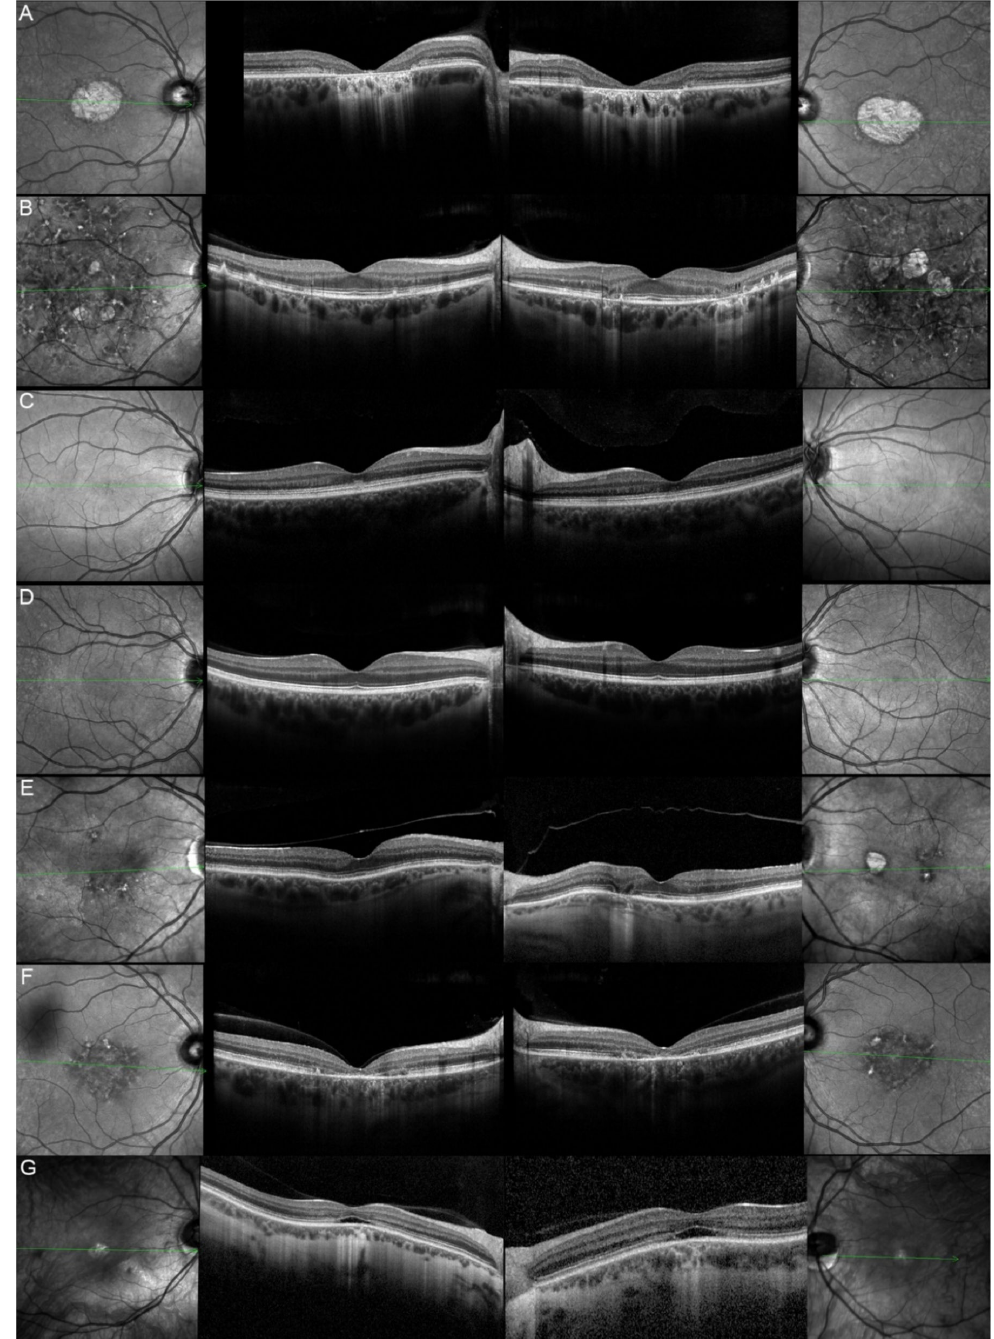
Figure 8. Optical coherence tomography (OCT) of patients harboring the pathogenic c.810C>G, p.(Tyr270*) ELOVL4 variant. Patient 12/II.2 ( A ), patient 13/II.1 ( B ), patient 13/III.2 ( C ), patient 13/III.1 ( D ), patient 13/I.1 ( E ), patient 14/II.4 ( F ), and patient 15/II.3 ( G ). For each patient, green lines on FAF images indicate the scanning sections (left and right panels) of the OCT (middle panels). The left panels show the right eye, and the right panels the left one. The OCT findings are described in detail in Table